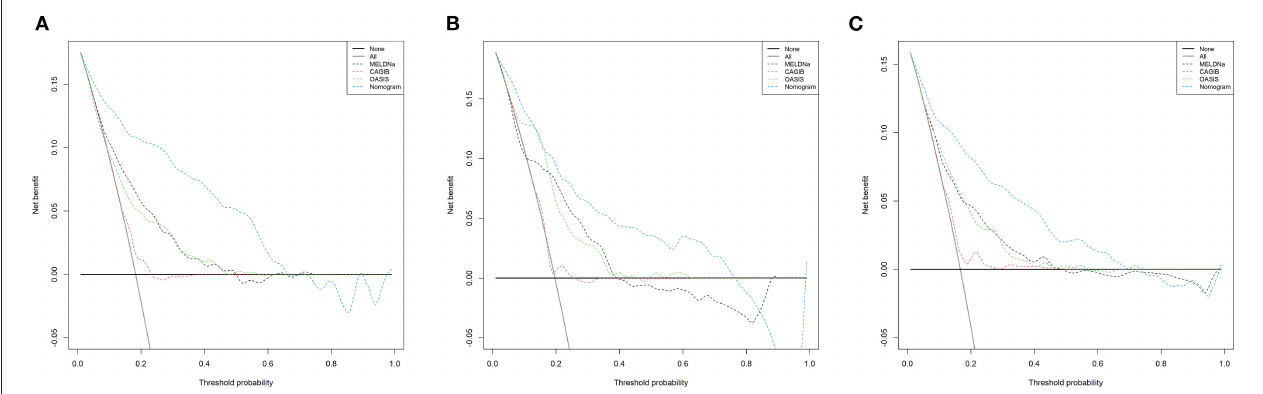
FIGURE 5 | DCA curves of the training cohort (A) , validation cohort (B), and MIMIC-IV cohort (C) . In the figure, the abscissa is the threshold probability, the ordinate is the net benefit rate. The horizontal one indicates that all samples are negative and all are not treated, with a net benefit of zero. The oblique one indicates that all samples are positive. The net benefit is a backslash with a negative slope. LCEV, liver cirrhosis with esophageal; MELD-Na, Model for End-Stage Liver Disease-Na; CAGIB, cirrhosis acute gastrointestinal bleeding; OASIS, Oxford Acute Severity of Illness